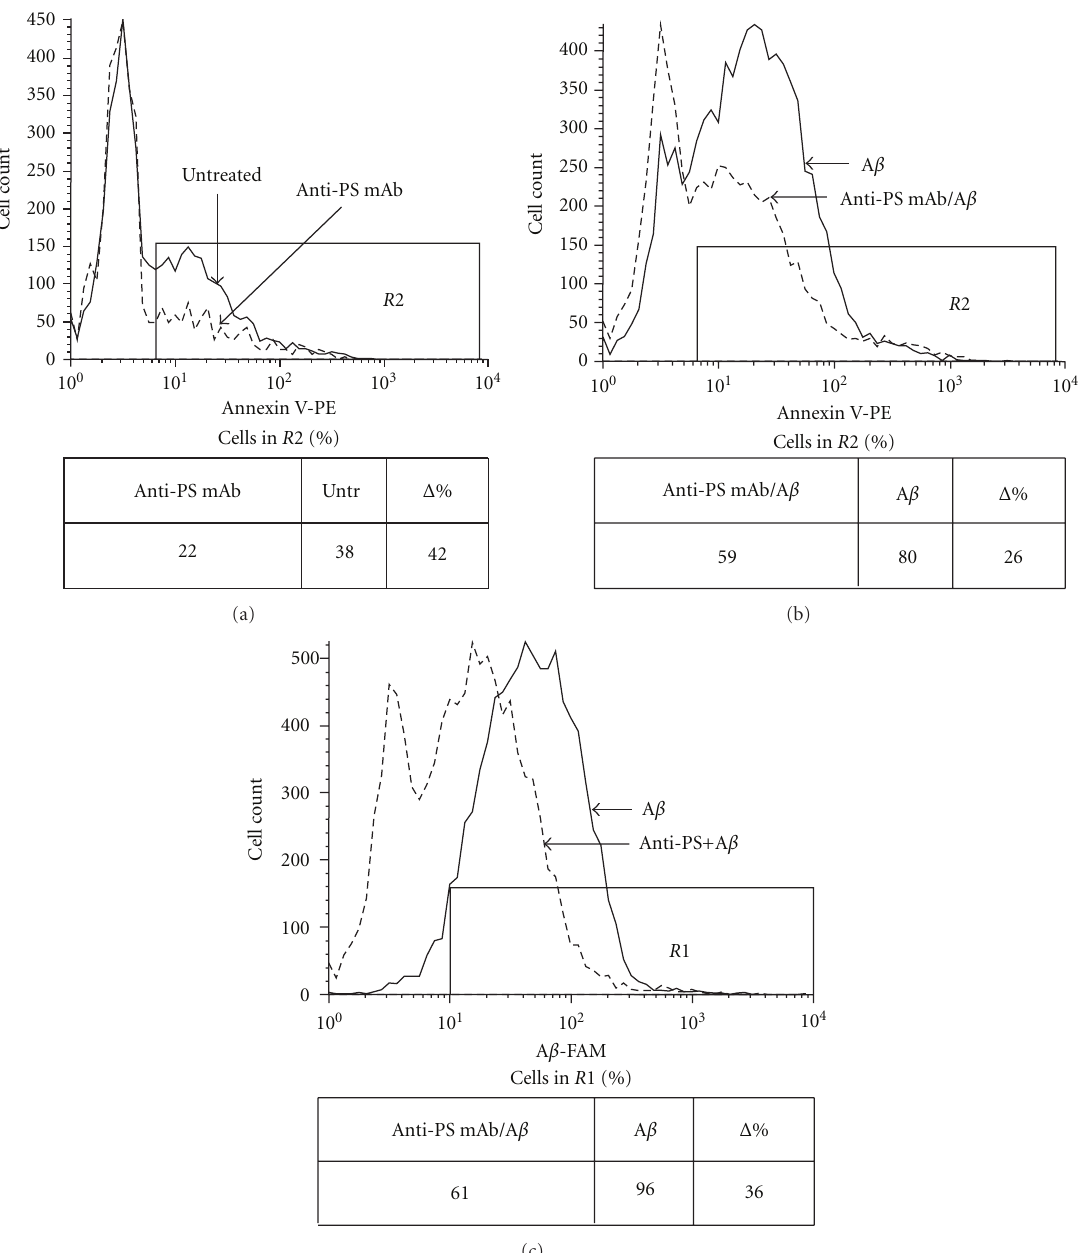
Figure 4: Specific antibody to PtdSer reduces the number of surface membrane binding sites for A β -FAM. PC12 cells were exposed for 20min to annexin V-PE, for PtdSer identification, and for 6 hrs to A β -FAM to study A β -FAM binding before and after treatment with anti-PtdSer monoclonal antibody (Anti PtdSer mAb). The fluorescence histograms in (a) show that cells treated with anti-PtdSer mAb reduced the percentage of PtdSer + cells in gate R 2 by 42% of the untreated value. The fluorescence histograms in (b) show that the combined treatment of anti-PtdSer mAb and A β -FAM reduced the percentage of PtdSer + cells in gate R 2 by 26% of the value observed after treatment with A β -FAM alone. The fluorescence histograms in (c) show that A β -FAM binding, measured as A β + cells in R 1, is also reduced, by 36%, when cells are pretreated with anti-PtdSer mAb. The tables in each panel show the percentage of PtdSer + and A β + cells in gates R 2 and R 1, respectively and Δ % represents the percentage of the